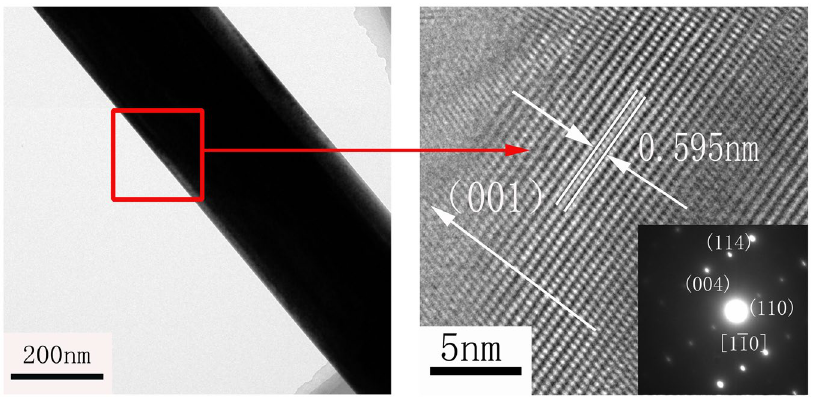
Figure 9. TEM and HRTEM images and SAED pattern of α -HH whiskers prepared in the presence of 0.25%